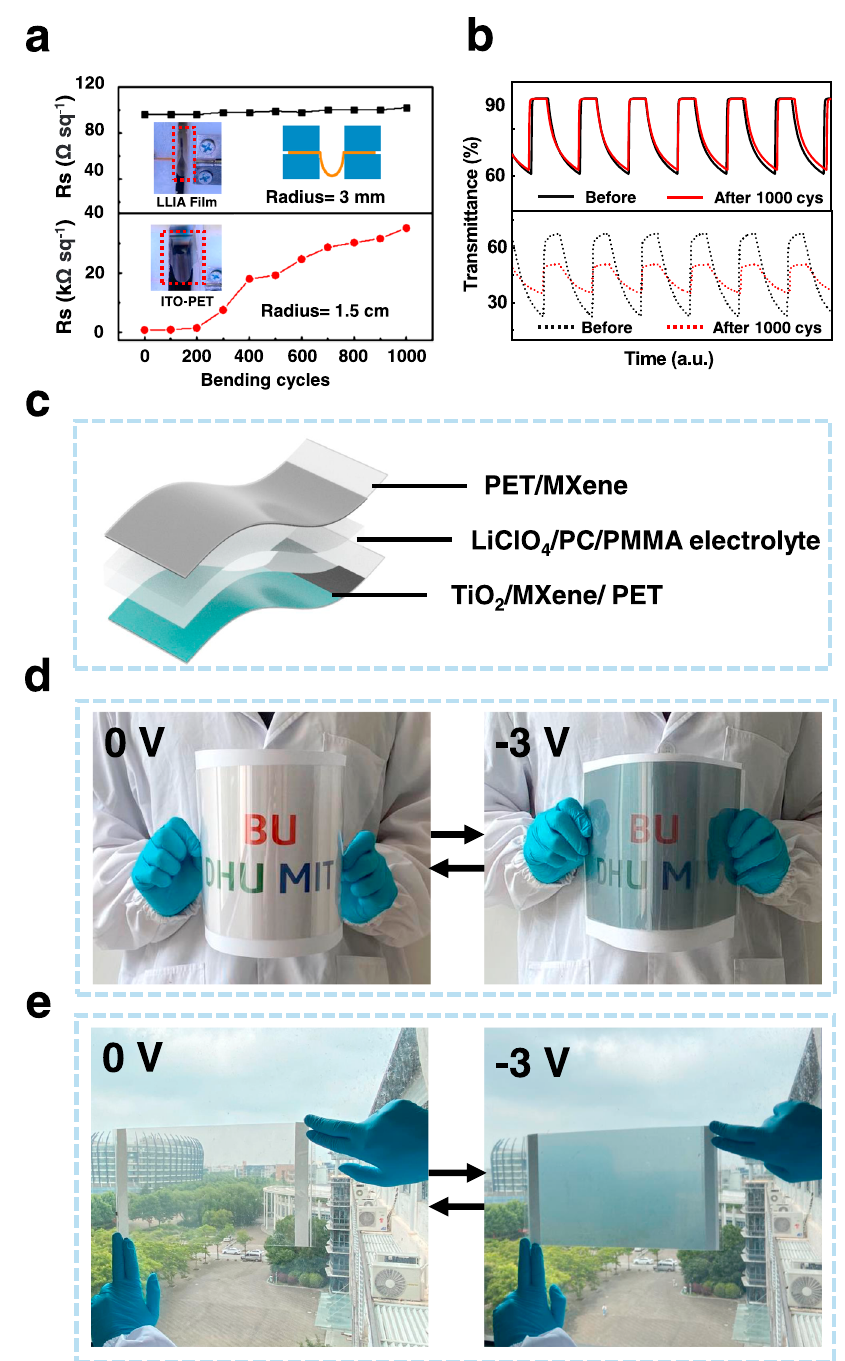
Fig. 5 Mechanical properties of the TiO 2 /Ti 3 C 2 Tx heterostructure and demonstration of a large-area fl exible EC device. a Comparison of the sheet resistance ( R s ) of the LLIA Ti 3 C 2 T x /PET and the ITO/PET fi lms after 1000 bending cycles; b Comparison of the electrochromic switching behaviors of the LLIA TiO 2 /Ti 3 C 2 T x /PET and the ITO/PET fi lms after 1000 bending cycles; c Schematic diagram of the fl exible solid electrochromic device; d , e As-prepared solid electrochromic device with an A4 paper size (about 20 × 30 cm) is d triggered in bending state and e attached on a